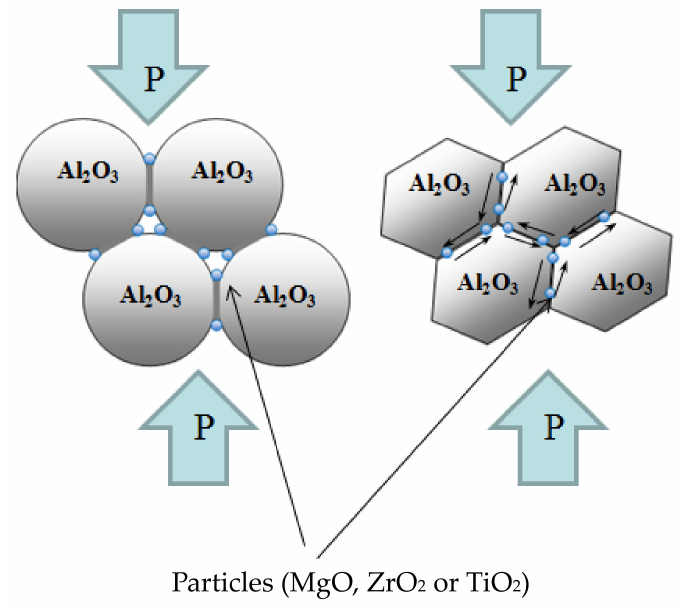
Figure 10. Scheme of arrangement of particles of the second